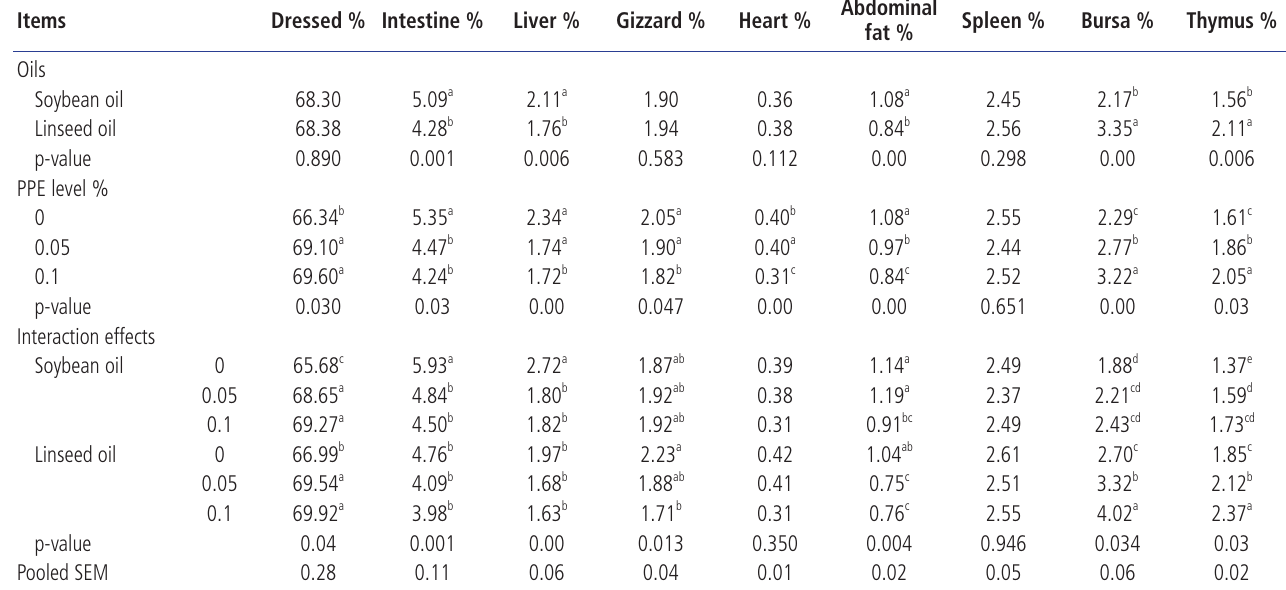
The effects of different dietary levels of PPE with different oil sources and their interactions on the antioxidant status of breast muscles and the immunity of broiler chickens are shown in Table 9. The addition of PPE to broiler ration, either with soy- Table 6. Effects of different dietary levels of pomegranate peel extract with different oil sources and their interactions on broiler chickens’ carcass traits